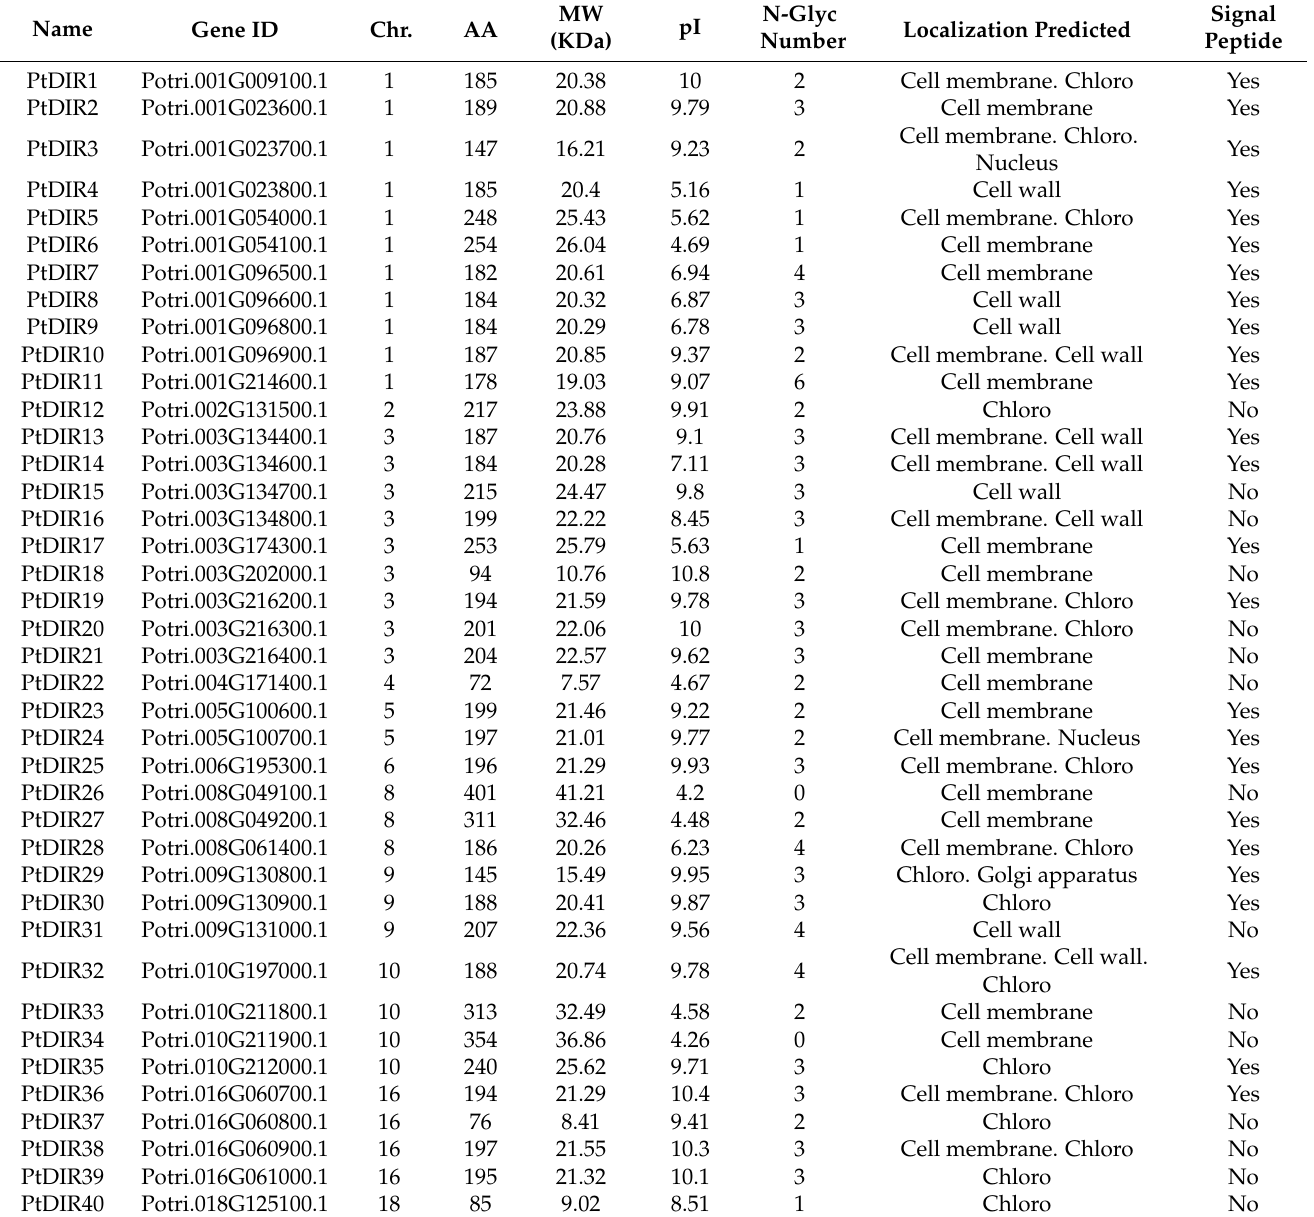
Table 1. Features of PtDIRs identified in P.